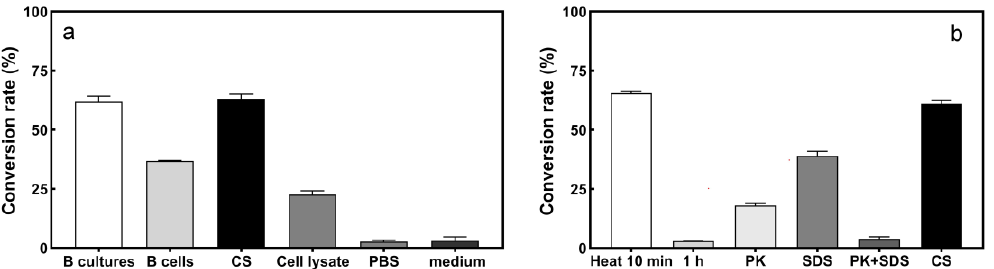
Figure 3. Location of active components by strain L1 and the effect of different treatments on CS. ( a ) S 2 − conversion rate of the B cultures, B cells, CS, and cell lysate of strain L1; ( b ) the S 2 − conversion rate of CS under different treatments.